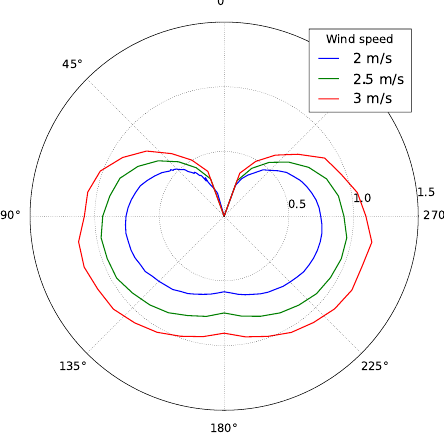
Figure 10. Polar diagram of the sailboat model for a 2 m 2 sail